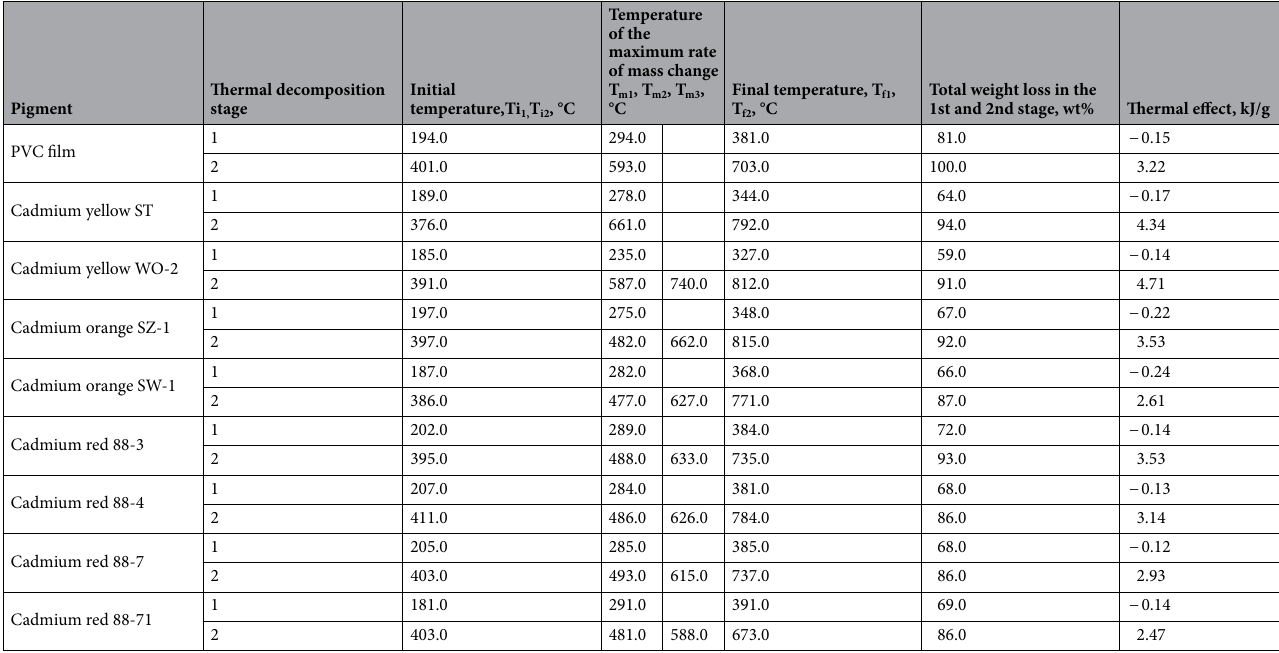
Table 4. PVC membranes with cadmium